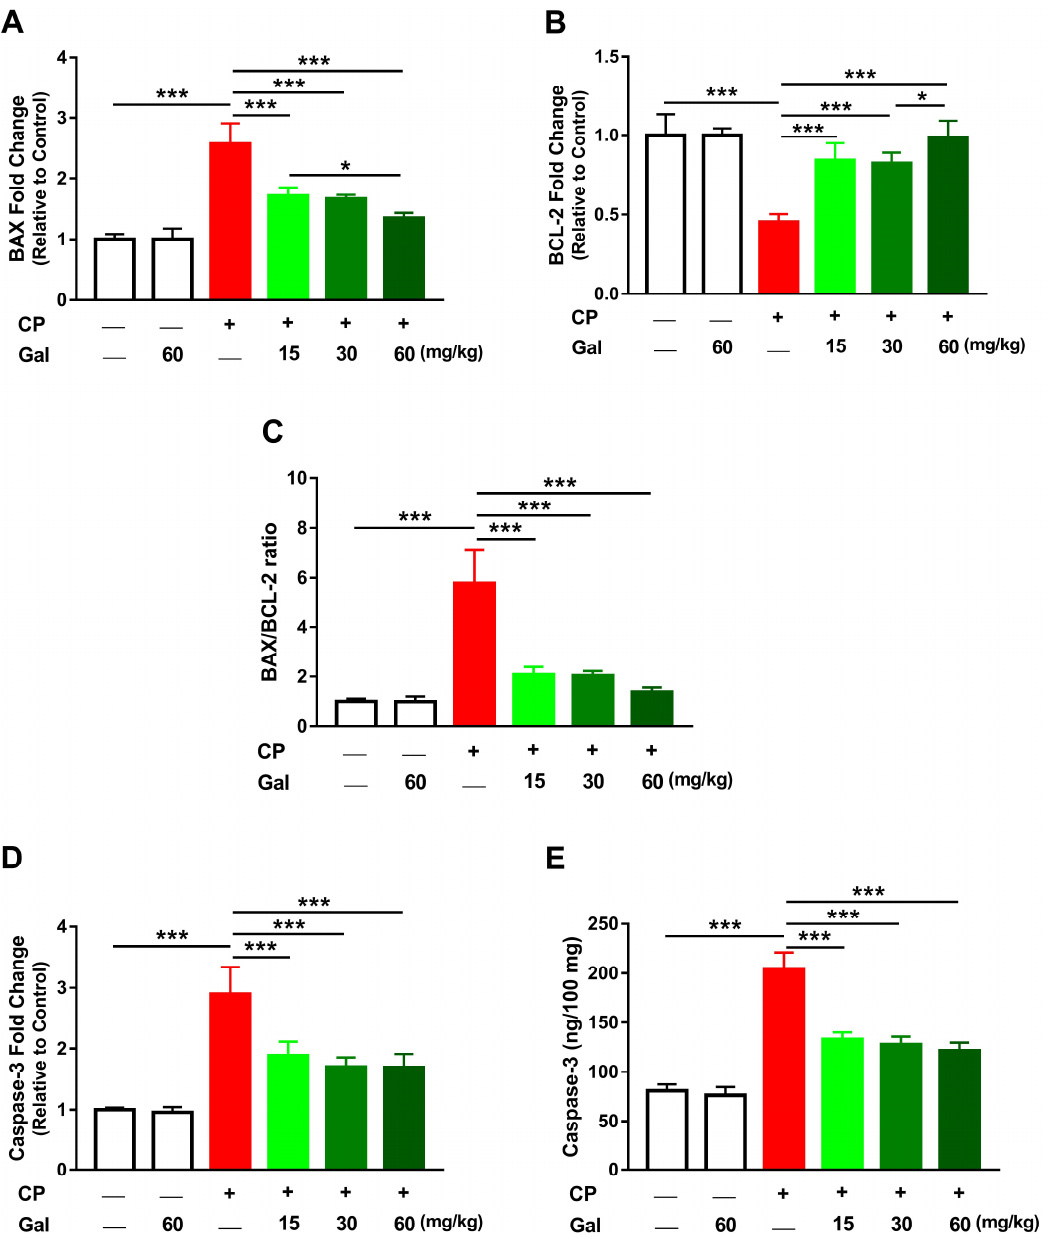
Figure 7. Galangin (Gal) attenuates CP-induced hepatic apoptosis in CP-intoxicated rats. Gal increased BCL-2 ( B ) and decreased ( A ) BAX, ( C ) BAX / BCL-2 ratio, ( D ) caspase-3 mRNA, and ( E ) caspase-3 activity. Data are mean ± SEM, ( N = 6). * P < 0.05 and *** P < 0.001.